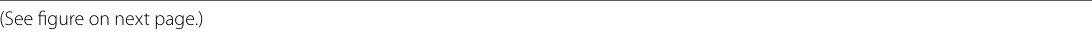
200 μm; scale bar in bone resorption pit picture 500 μm. = = SEM. * P < 0.05, ** P < 0.01, *** P < 0.005 and **** P < 0.001 as ±